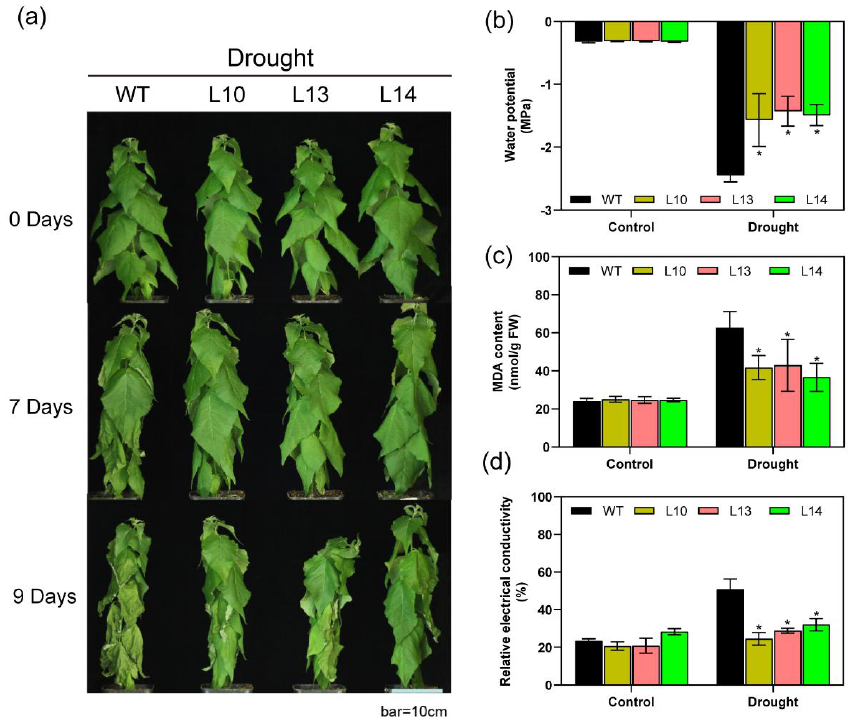
Figure 3. PagPIP2;10 overexpression enhances drought stress tolerance in poplars. ( a ) Effects of drought stress on the growth of wild-type (WT) plants and PagPIP2;10ox lines (L10, L13, and